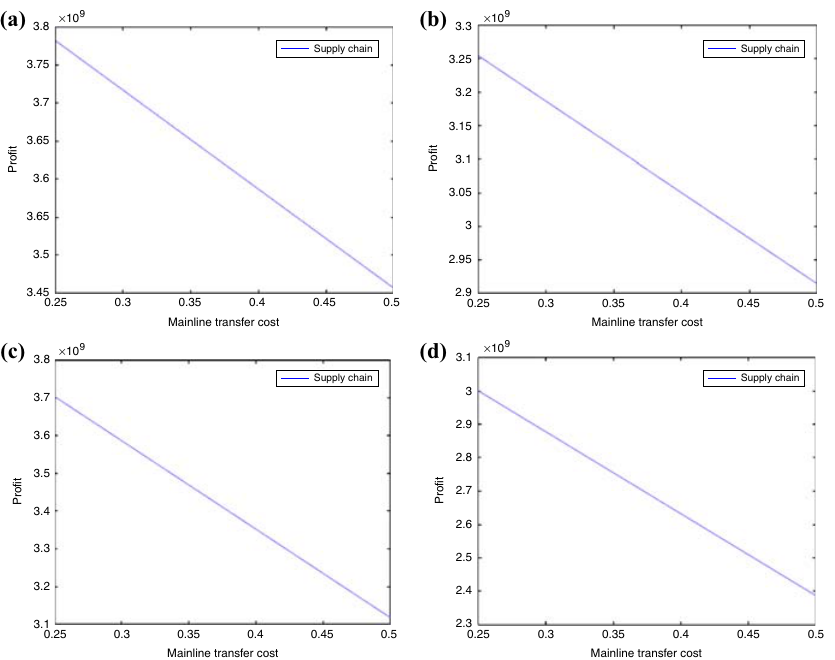
Figure 5. The impact of mainline transfer cost change on the profit of IBWT supply chain without/with fairness concern